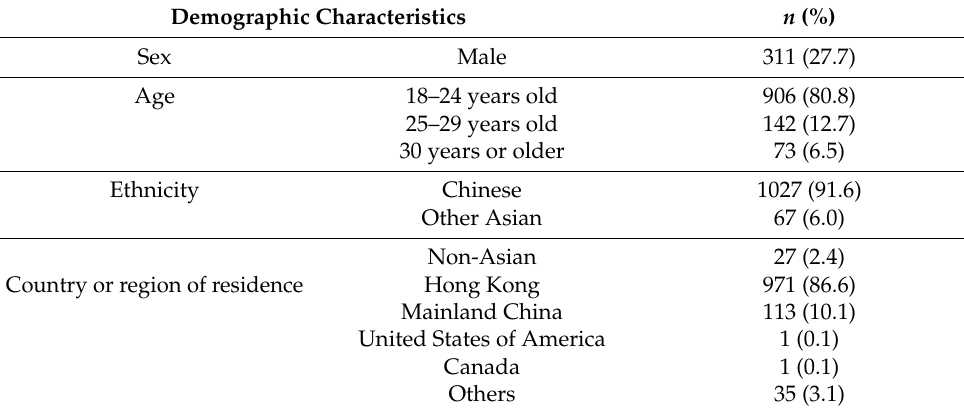
Table 1. Students’ characteristics ( n =